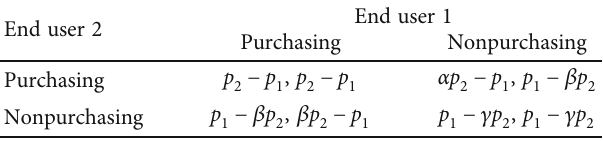
Table 4: Income matrix between end